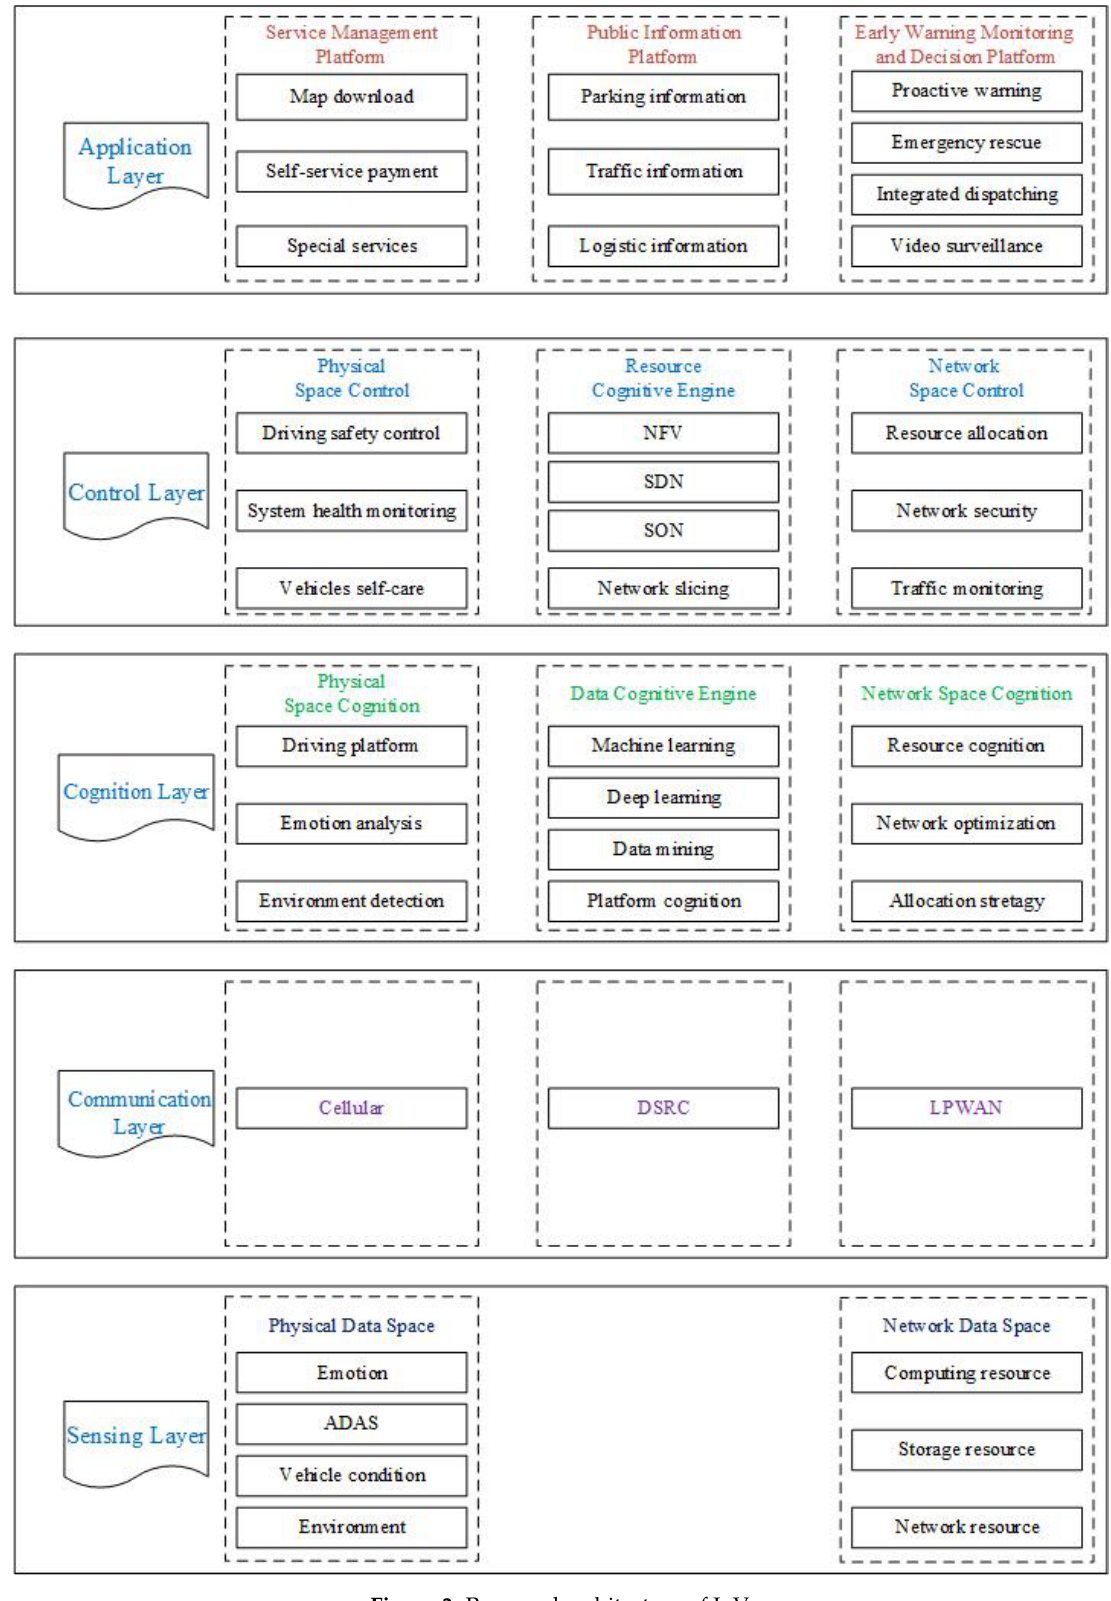
Figure 3. Proposed architecture of